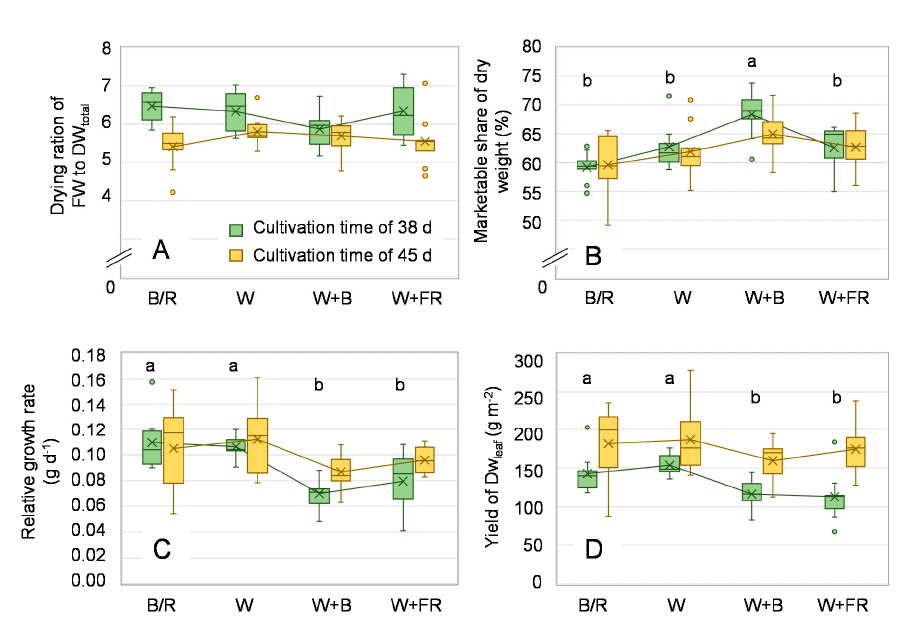
Figure 5. ( A ) Drying ratio as percentage of DW total :FW, ( B ) share of marketable leaf dry weight in relation to DW total , ( C ) relative growth rate per day and ( D ) yield of leaf dry weight per square meter cultivation area (plant density of 375 plants per m − 2 based on the experimental setup) of marjoram growth grown under four di ff erent light treatments. All results are based on a cutting height of 5 cm. Di ff erent letters represent significant di ff erences between light treatments at p <